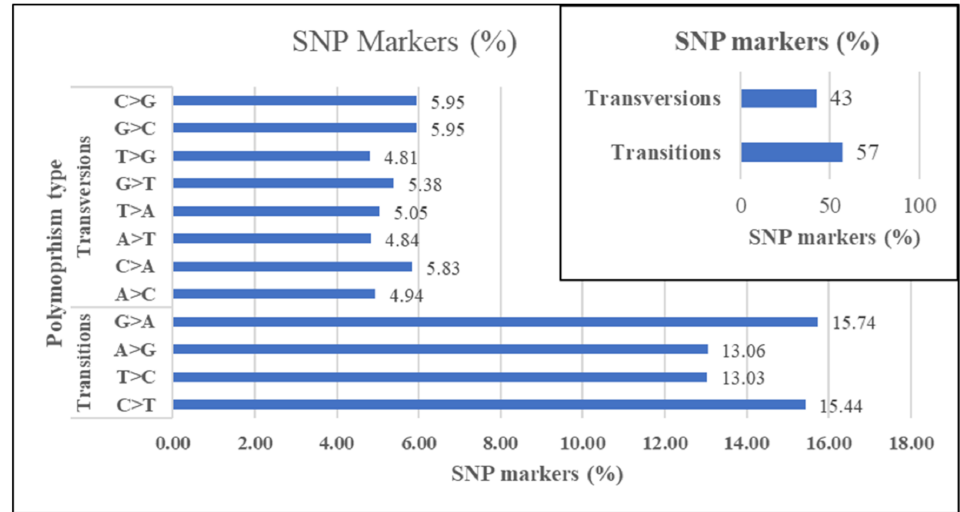
Figure 3. Proportion of SNP markers by transition and transversion